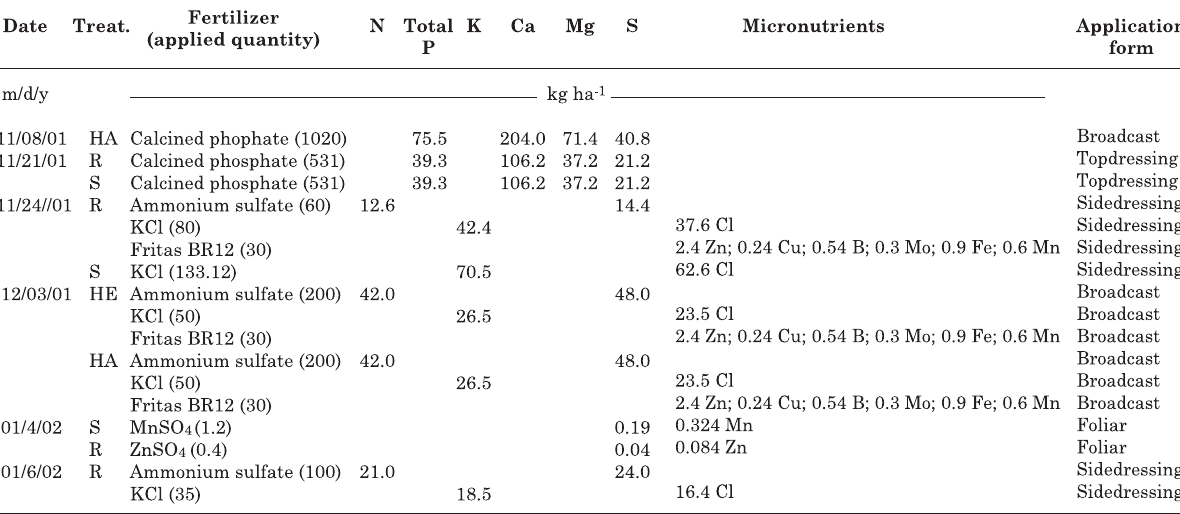
Table 1. Schedule of fertilizer application in the recovery treatment of low-productivity pasture with the respective sources, nutrient contents and application form